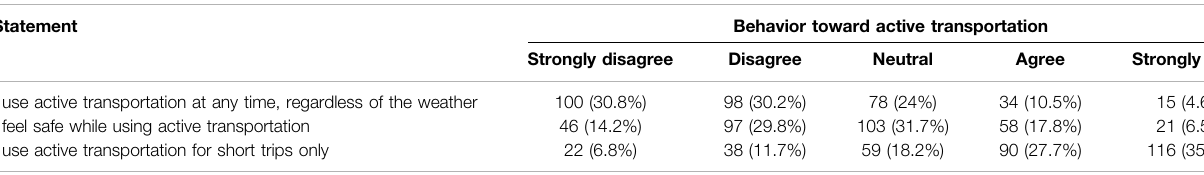
TABLE 4 | Behavior toward active transportation.